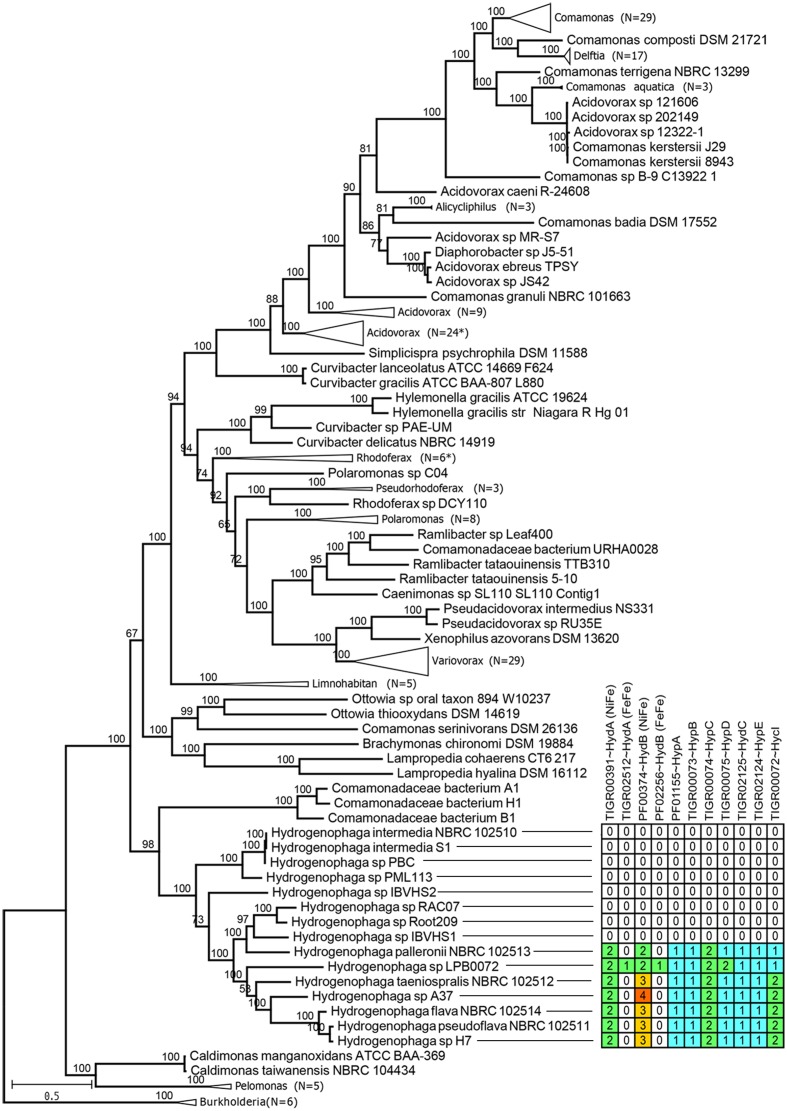
Maximum likelihood phylogenomic tree of the family Comamonadaceae. The tree was rooted with members of the genus Burkholderia belonging to the family Burkholderiaceae, as the outgroup. Numbers in brackets indicate the number of branches collapsed. Asterisks indicate the presence of one member with inconsistent taxonomic labeling, e.g., different genus name within the collapsed branch. Numbers above branches indicate ultra-fast bootstrap support values. Table next to the Hydrogenophaga clade show the number of proteins showing significant hits to HMM profiles associated with bacterial hydrogenase system.